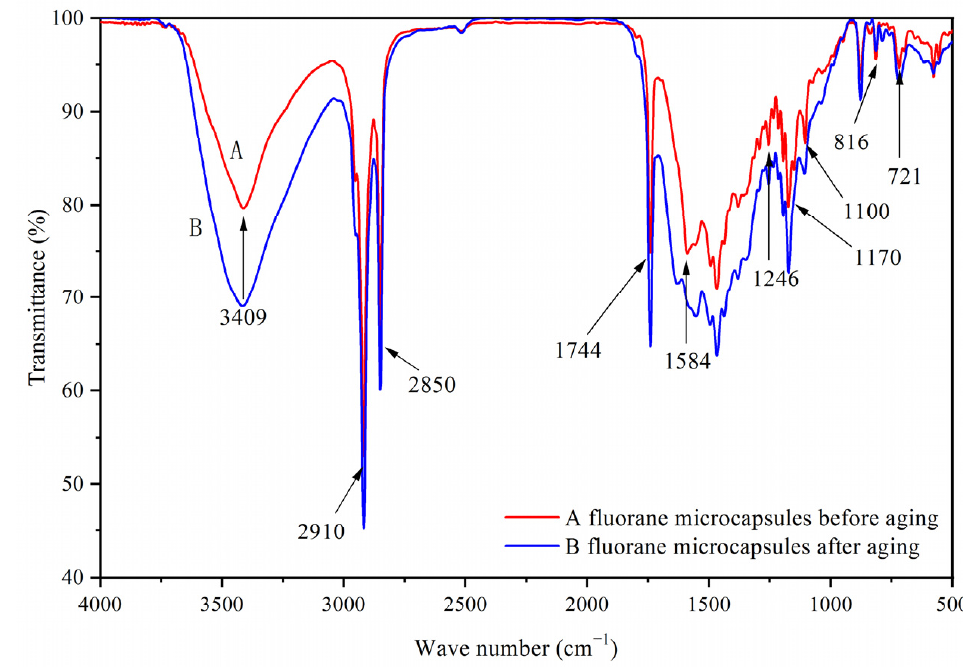
Figure 3. Infrared spectrum of fluorane microcapsules.